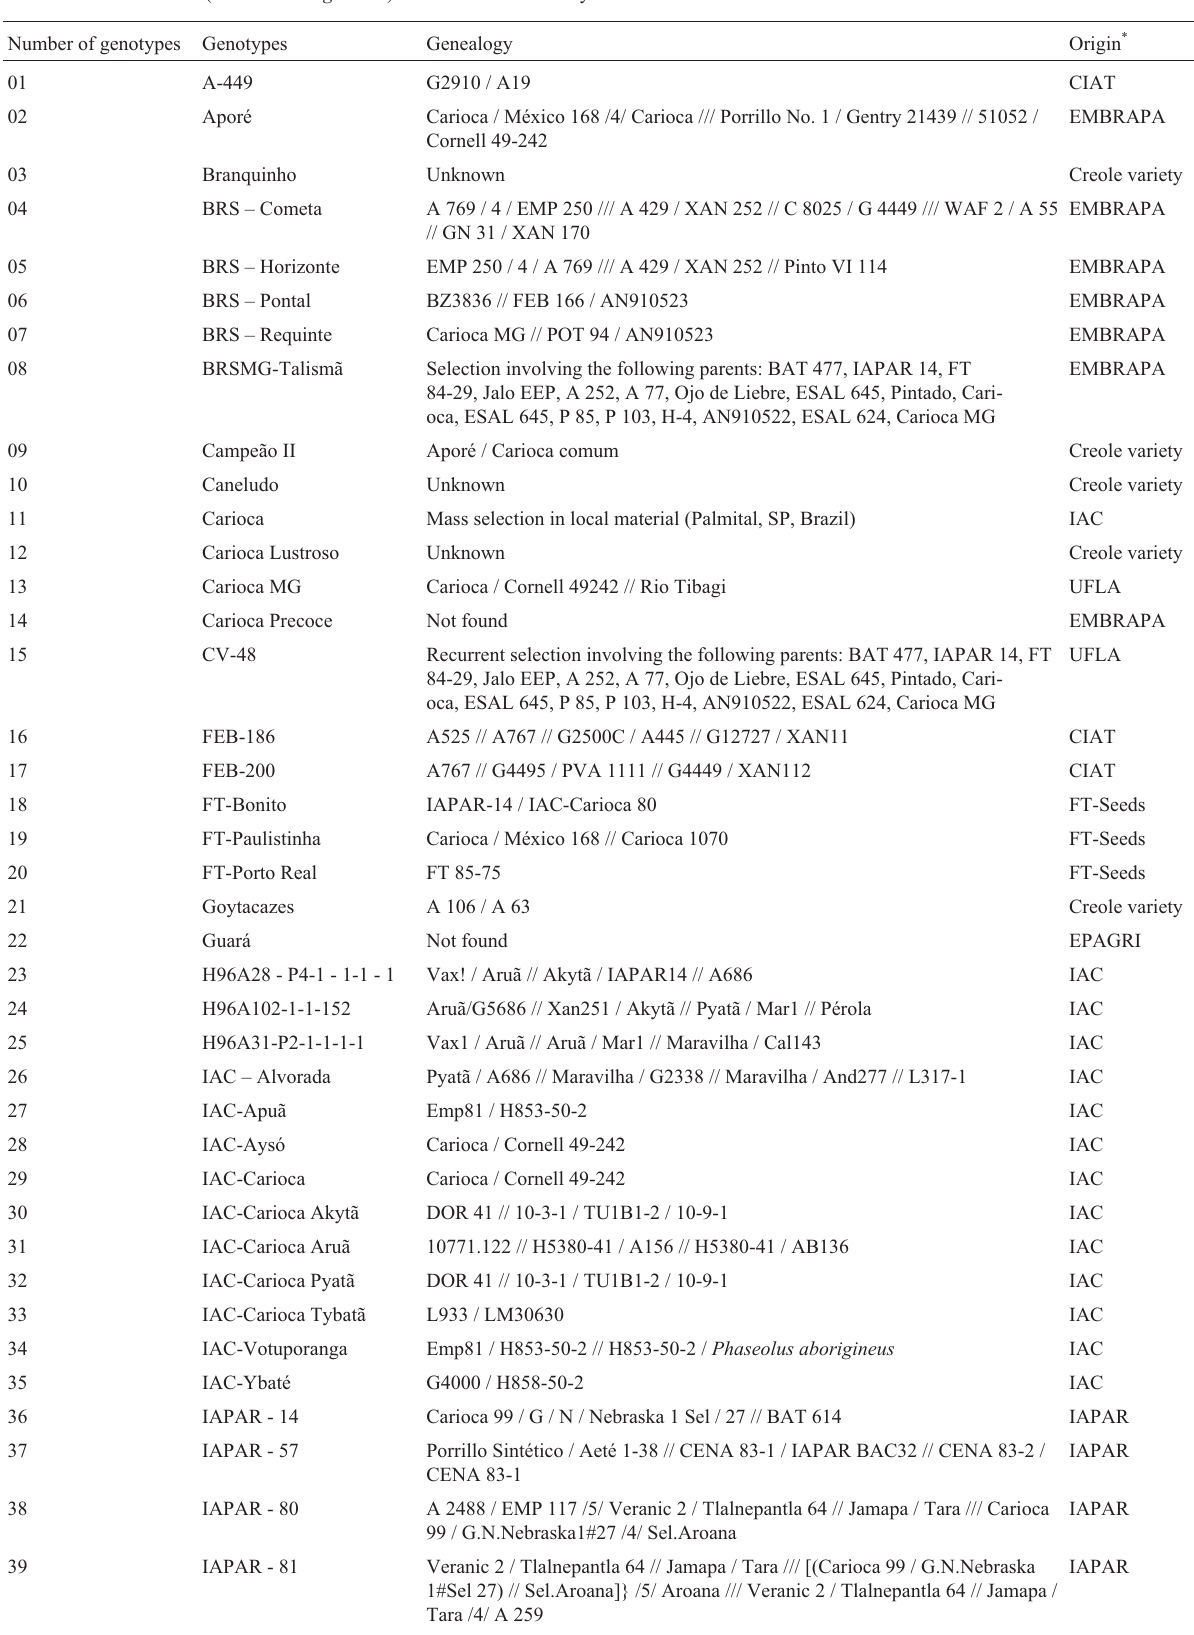
Table 1 - Common bean ( Phaseolus vulgaris L.) accessions evaluated by SSRs and AFLPs. Number of genotypes